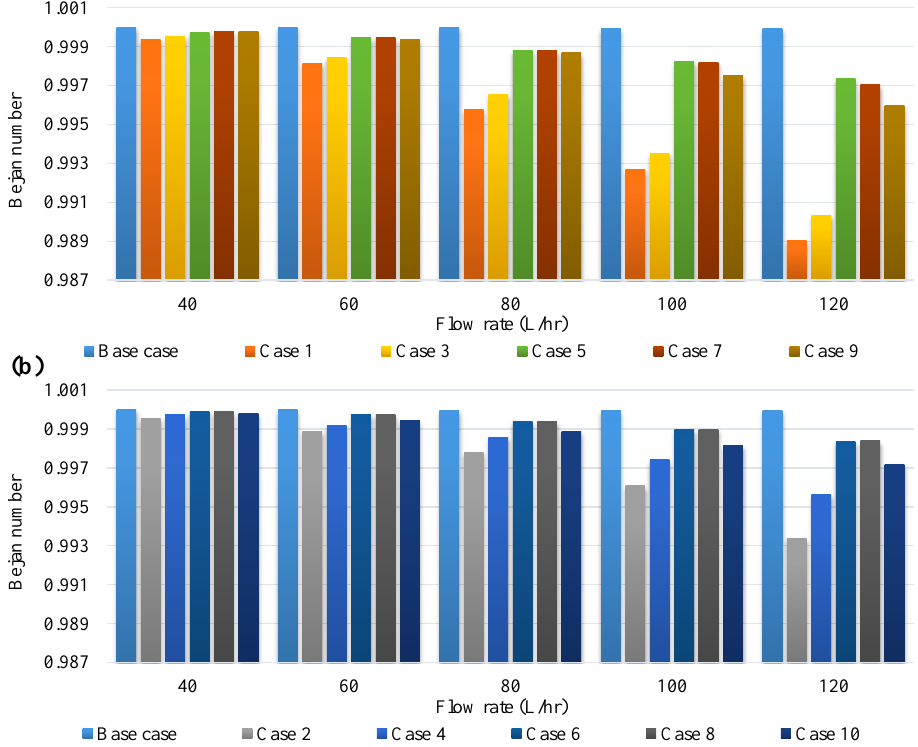
Figure 5. Bejan number at different flow rates for the inlet temperature of 20 °C for ( a ) fully porous cases and ( b ) semi-porous cases.